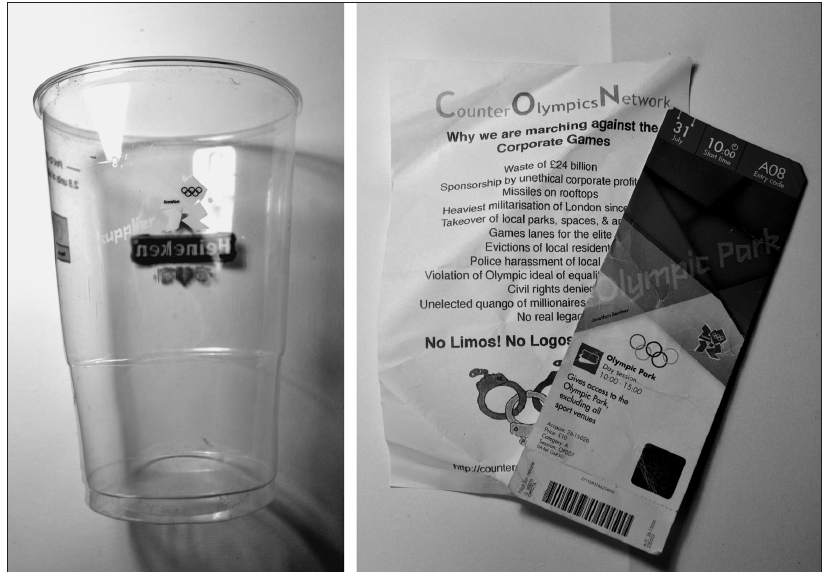
Figure 4: Traces of London 2012. Left: A promotional plastic Heineken Pint Glass used by the author on 31 st July 2012 from a stand inside the Olympic Park (£4.80 a pint). Right: A ticket and protest flyer from the Games. Photographs: © Jonathan